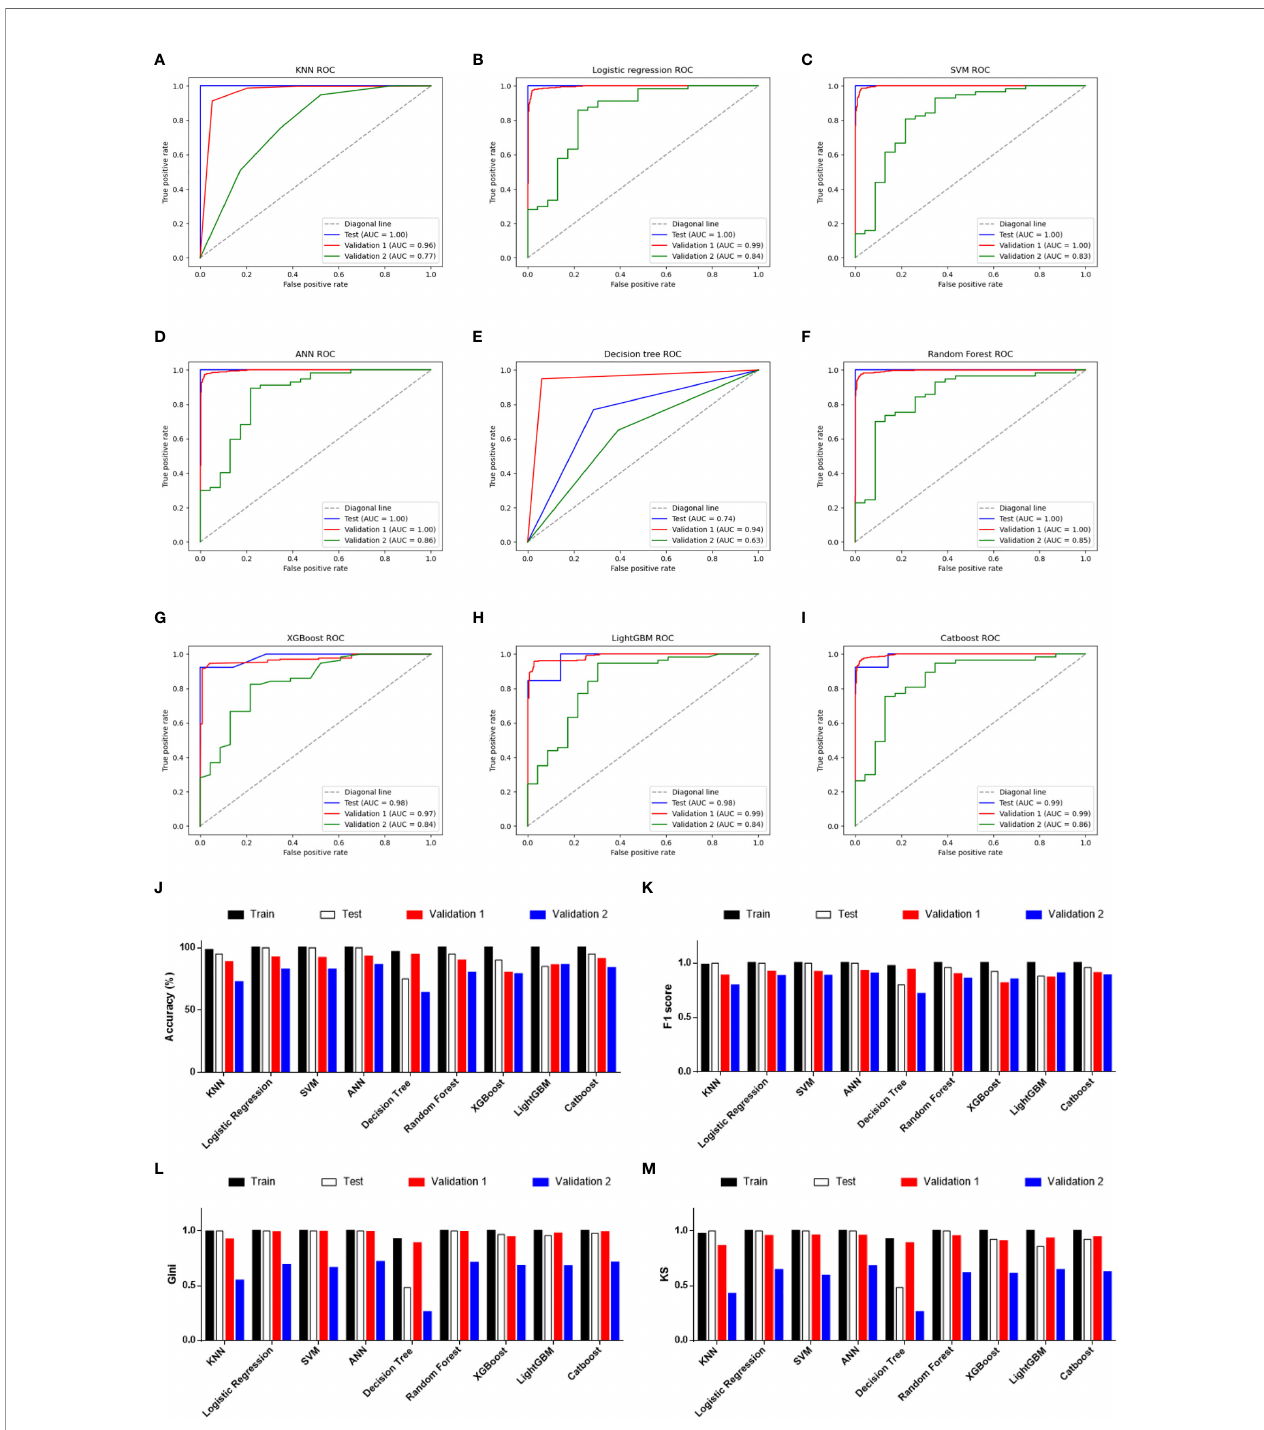
FIGURE 3 | Performance evaluations of diagnostic classi fi ers based on 9 algorithms. (A – I) ROC curves for evaluating the predictive performance of the diagnostic models respectively based on K-Nearest Neighbor (A) , logistic regression (B) , Support Vector Machine (C) , Arti fi cial Neural Network (D) , decision tree (E) , random forest (F) , XGBoost (G) , LightGBM (H) , and CatBoost (I) . Data from GSE98394 were randomly divided into a training set (not shown due to the AUCs were extremely close to 1.0 in all classi fi ers) and a testing set (blue line) according to 7:3. Validation 1: the combination of TCGA-SKCM & GTEx-SKIN (red line). Validation 2: GSE112509 (green line). (J) Columns showing the accuracy (%) of each classi fi er in different datasets. (K) Columns showing the F1 score of each classi fi er in different datasets. (L) Columns showing the Gini index of each classi fi er in different datasets. (M) Columns showing the KS value of each classi fi er in different